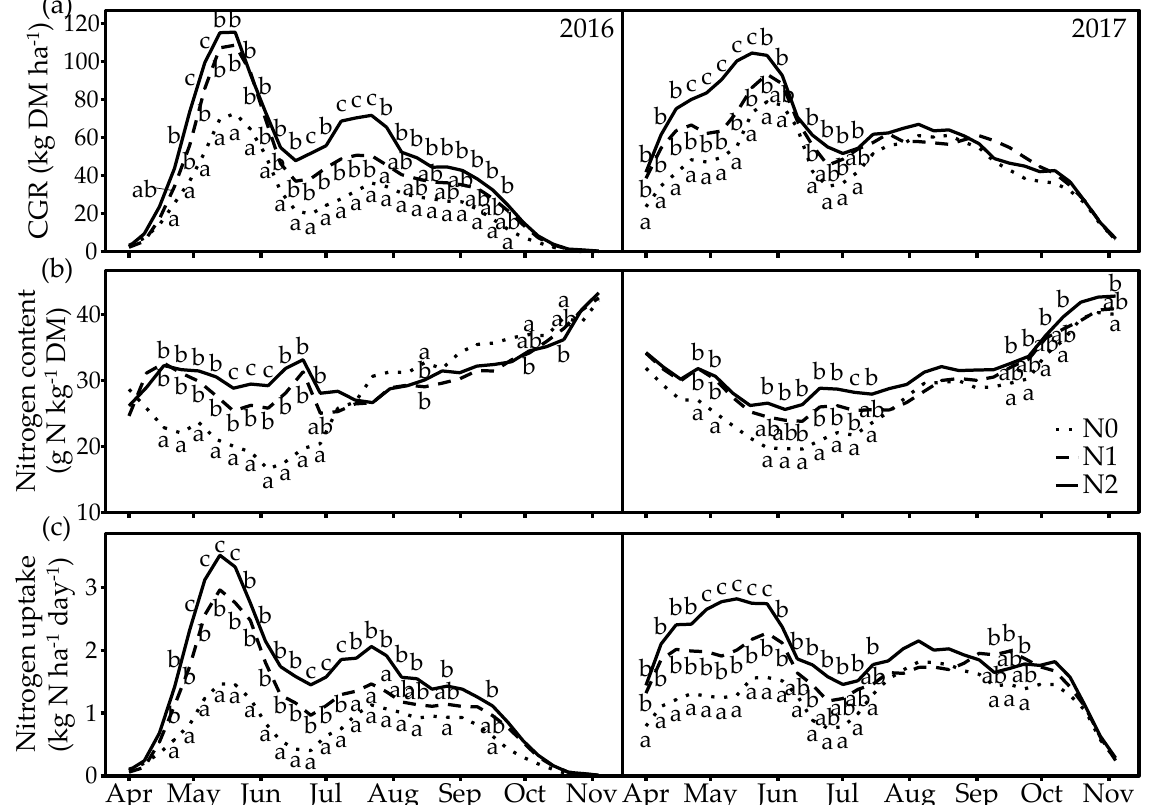
Figure 2. ( a ) Mean daily crop growth rate (CGR), ( b ) mean nitrogen content and ( c ) mean daily nitrogen uptake of the total herbage harvested during the vegetation period of 2016 and 2017 for three N application rates (0 (N0), 140 (N1) and 280 (N2) kg N ha − 1 ). Mean values at the same harvest date with different superscripts differ between N application rates ( p ≤ 0.05).